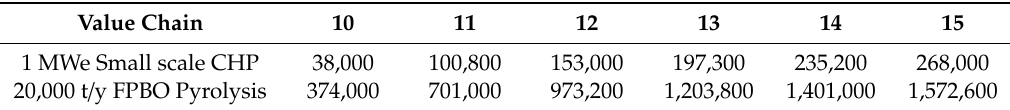
Table 7. Added value for the region in terms of annual profit (in € ) from the cultivation of Miscanthus per value chain for di ff erent crop